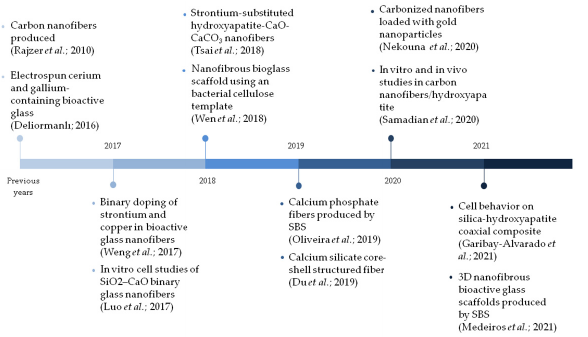
Figure 6. Main studies addressing ceramic nanofibers applied in bone regeneration applications over the last six years [23,55,56,74,114–121] The literature indicates an association between the inherent characteristics of the na- nometric character of the nanofibers bioceramics microstructure (fiber topography, ar- rangement/disposition of nanofibers, pore sizes and distribution, etc.) and the chemical- biological properties of these materials, generally with a synergism between them, which implies the extremely satisfactory performance in cell adhesion, proliferation, and differ- entiation in the in vitro and in vivo assays of the nanofibrous scaffolds [28,55,122–128]. CaP-based bioceramics, such as HA, β -TCP, Ca 3 (PO 4 ) 2 , and biphasic calcium phos- phate (BCP), a mixture of HA and β -TCP composed of the same ions as bone, are inor- ganic materials that show excellent biocompatibility and have received great attention for bone repair applications, due to their chemical and structural similarities with the inor- ganic phase of human bone. They have also been shown to be efficient bone substitutes that respond well to material resorption/bone replacement events, being widely used in the hard tissue replacement area, as well as being used in various biomedical applications aiming at bone regeneration [129]. Among them, β -TCP and HA are the most used mate- rials for bone regeneration, since they have a similar composition to the inorganic constit- uents of bone, allowing the production of apatite, the main inorganic bone component. When compared to β -TCP, HA is slowly reabsorbed and undergoes a little conversion to a bone-like material after implantation. However, β -TCP scaffolds generally exhibit lower strength than HA scaffolds with the same porosity, which makes their use in bone repair challenging [130–133]. Holopainen and Ritala [122] produced HA fibers through the ES technique, followed by annealing (electroblowing), and observed that fibrous membranes had fiber mean di- ameters ranging from 200 ± 70 to 330 ± 140 nm, depending on the solution characteristics and the experimental parameters used. The relative humidity (RH) chosen for spinning was an important factor for the fiber properties, with it being noticed that a RH greater than 25% promotes an increase in the amount of wet droplets that reaches the collector, hampering the collection of continuous fibers, while smaller RH values, generally, induce the formation of smoother and larger diameter fibers. In spinning techniques like this, as well as in ES and SBS, the RH is a parameter that is difficult to control, once it is related to the climatic characteristics of the environment where the spinning takes place. It was also shown that randomly oriented HA fibers induce the fast formation of a homogeneously apatite layer around the fibers after a 6 h immersion in simulated body fluid (SBF), being considered a high bioactivity material. In the same year, Yi, et al. [134] developed porous HA fibers loaded with bovine serum albumin (BSA) that exhibited good drug-controlling release properties, observing that, after three days of immersion in phosphate buffered saline solution (PBS), there was an abundant formation of nano-bone apatite on almost all surfaces of the glass fibers.